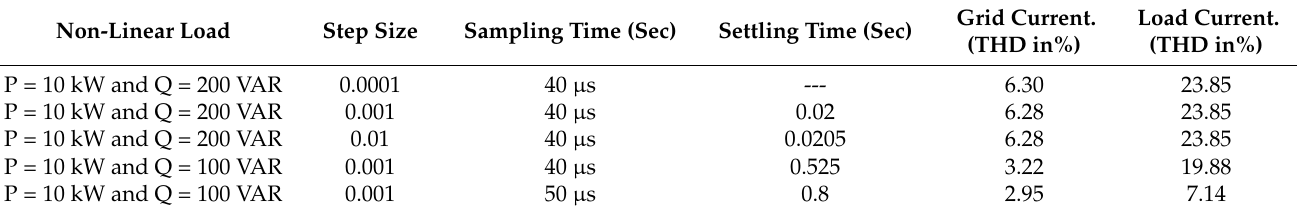
Table 4. Total harmonic distortion in the grid current with a change in linear load, sampling time and step size, iterations = 75, solar radiation is varying from 0 to 1000 W/m 2